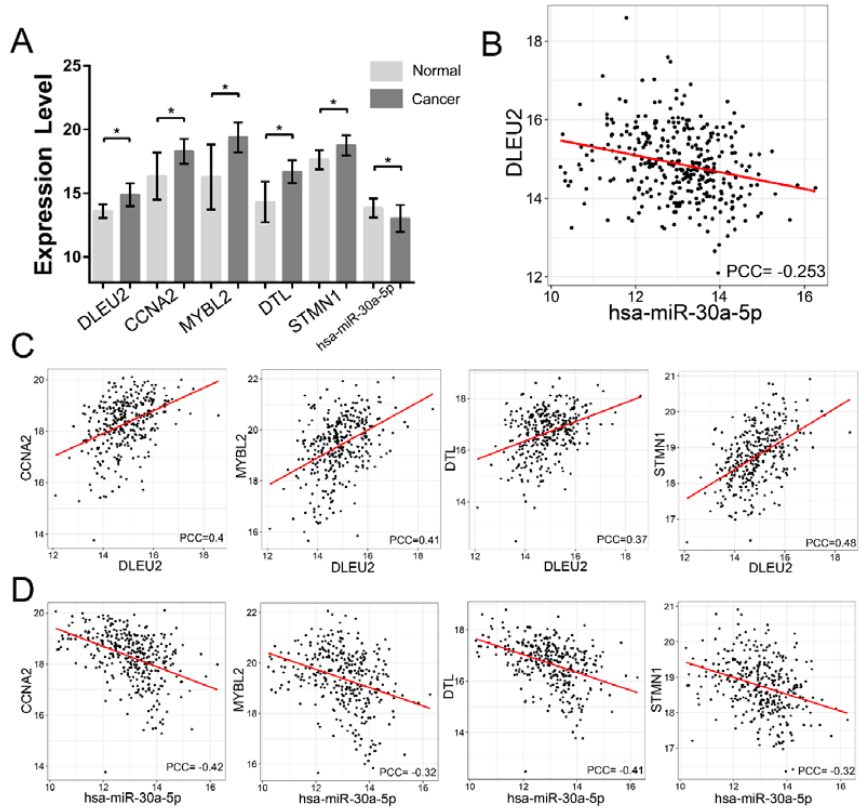
Figure 5. The expression levels and correlation of DLEU2 related DEMi and DEMs in GC. ( A ) The boxplot showed the expression levels of DLEU2 and DLEU2 related DEMs. * denotes p < 0.001; ( B ) The scatter plots showed the correlation of expression between DLEU2 and hsa-miR-30-5p; ( C ) The scatter plots showed the correlation of expression between DLEU2 and DLEU2 related DEMs; ( D ) The scatter plots showed the correlation of expression between DLEU2 related DEMs and hsa-miR-30-5p. All the data were obtained from